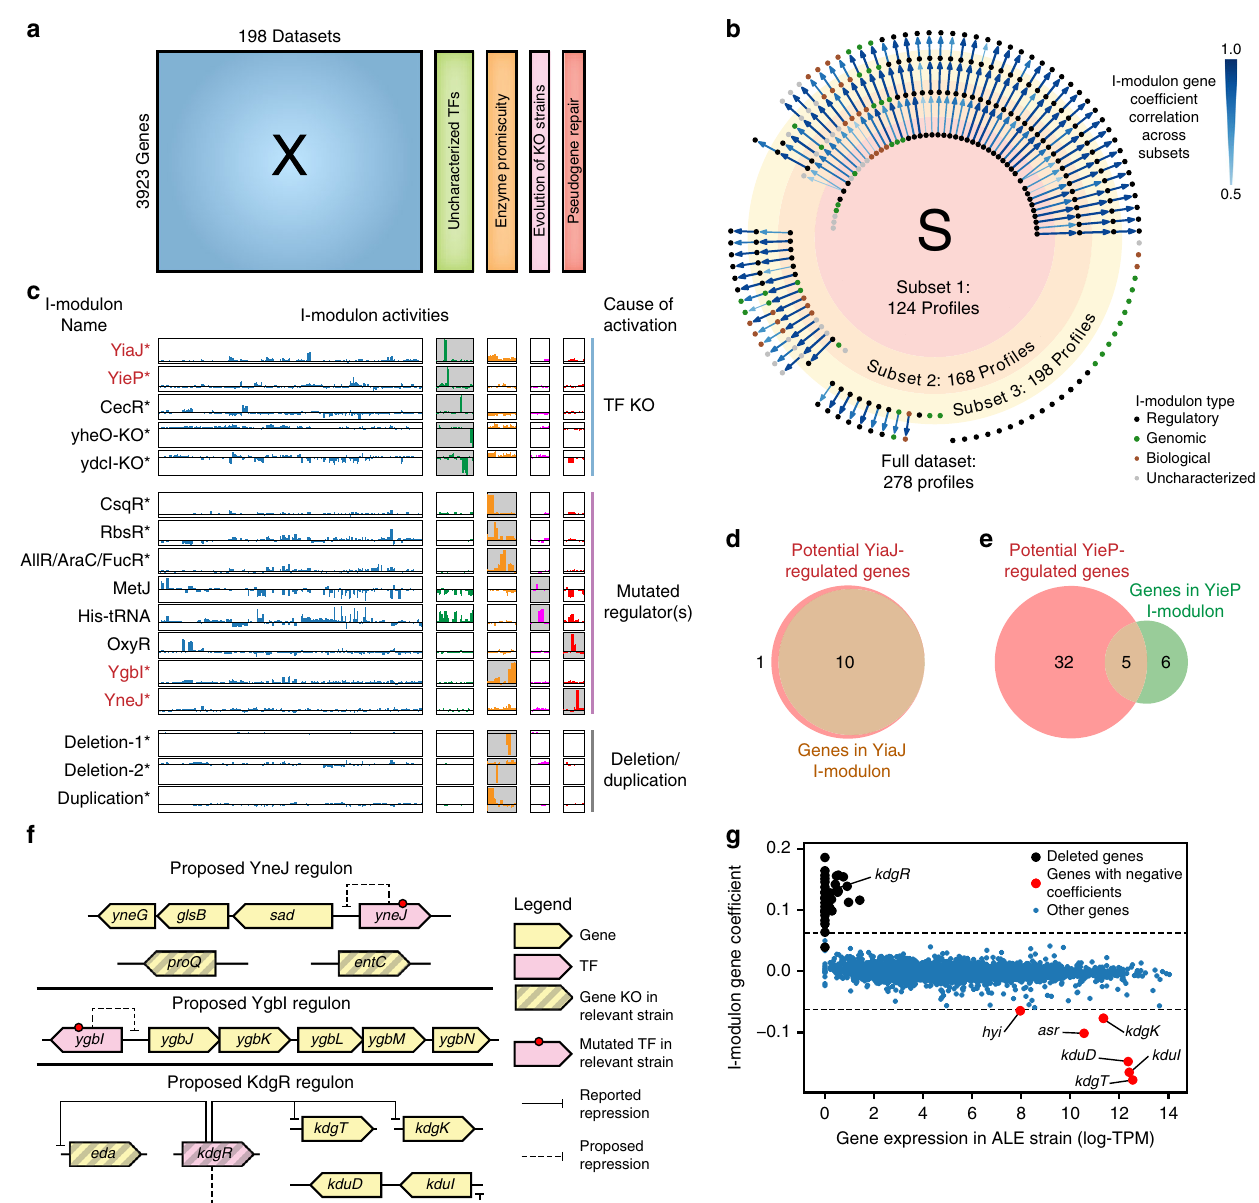
Fig. 4 ICA provides answers to unasked questions. a Schematic illustration of appending four new datasets 42 – 45 to PRECISE. b Comparison of ICA results on three nested subsets of the PRECISE compendium. Each node represents an i-modulon and is colored by type (e.g. regulatory or genomic). Components are linked by an arrow if their gene coef fi cients are correlated (Pearson R > 0.5). Arrow widths and color represent correlation strength. c Compendium- wide activities for selected i-modulons. Each bar represents the activity of the denoted i-modulon in a single expression pro fi le. Starred i-modulons were discovered after addition of the four new datasets. I-modulons in red font propose regulons for previously uncharacterized TFs. I-modulons are grouped based on the genetic perturbation (e.g. TF KO, mutation in regulator) that activated the speci fi c i-modulon. The dataset responsible for the i-modulon activation is highlighted in gray for each i-modulon. d Venn diagram comparing genes in the YiaJ i-modulon and genes with ChIP-exo determined binding sites for YiaJ. e Venn diagram comparing genes in the YieP i-modulon and genes with ChIP-exo determined binding sites for YieP. f Predicted regulatory roles based on i-modulons for YneJ, YgbI, and KdgR. g Scatterplot of gene expression in strain with 39-gene deletion against the Deletion-1 i-modulon gene coef fi cients. The Deletion-1 i-modulon has a negative activity for the strain with the deletion, indicating that genes with positive i-modulon coef fi cients are not expressed in this strain, whereas genes with negative i-modulon coef fi cients are over-expressed in this